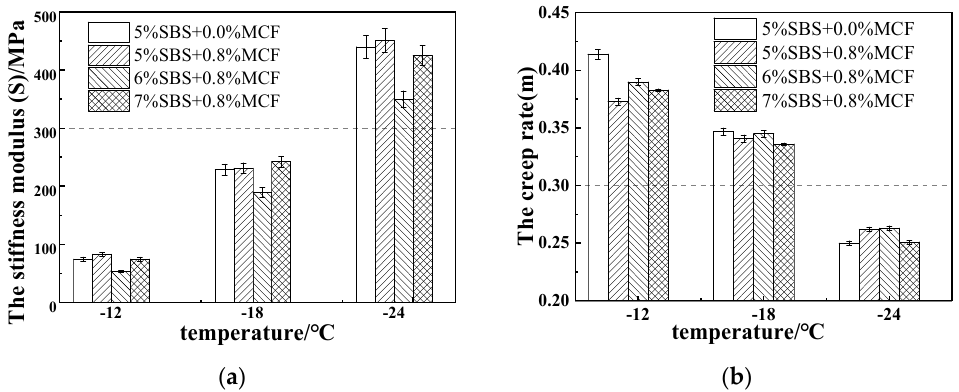
Figure 9. Low-temperature trabecular test results of modified asphalt at different temperatures: ( a ) Test results for S value; ( b ) Test results for m value.